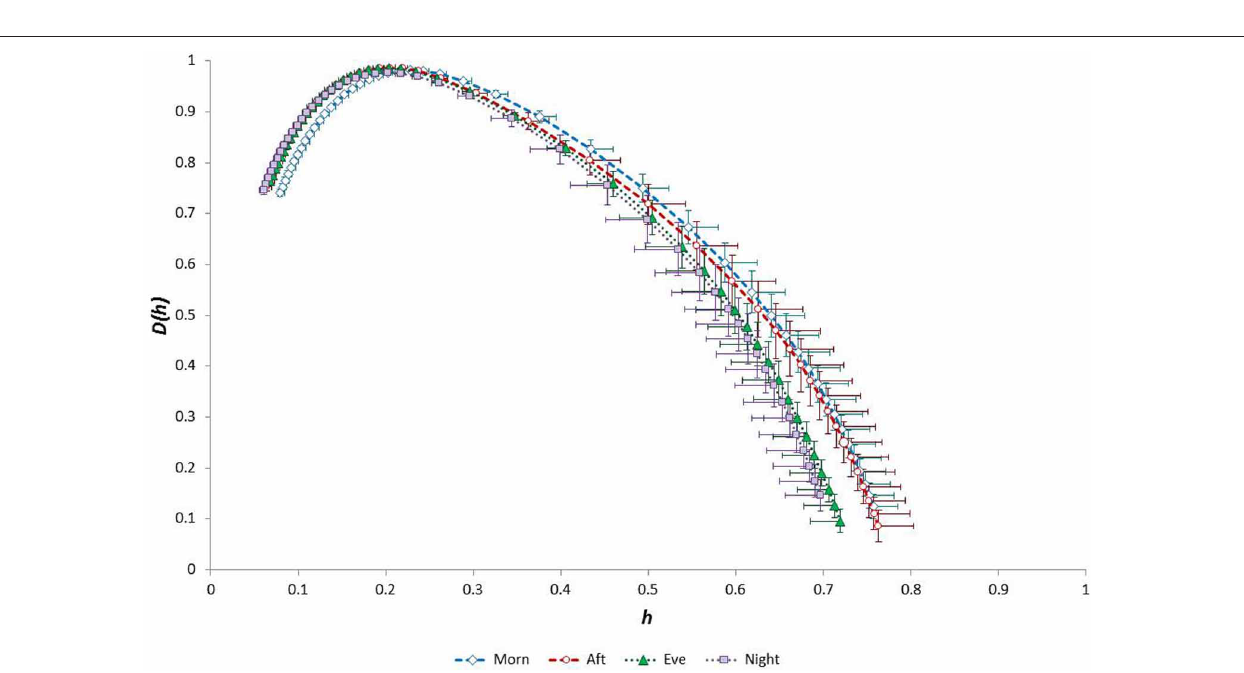
FIGURE 10 | Singularity multifractal spectra by “time of day” calculated for surrogate data (order-shuffled transformation of original data).